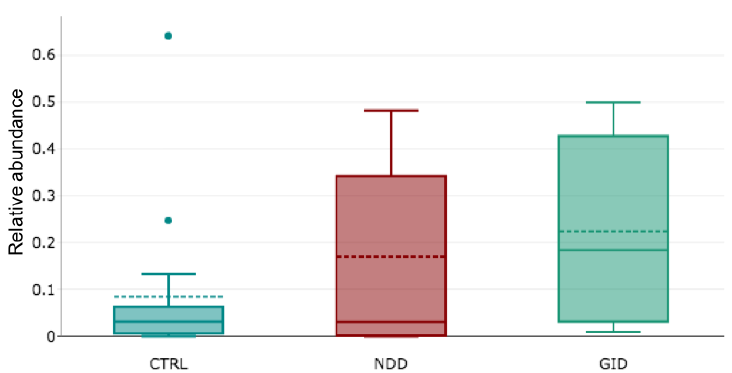
Figure 2. Box plot of relative abundance of Saccharomyces genus in CTRL, NDD and GID groups.